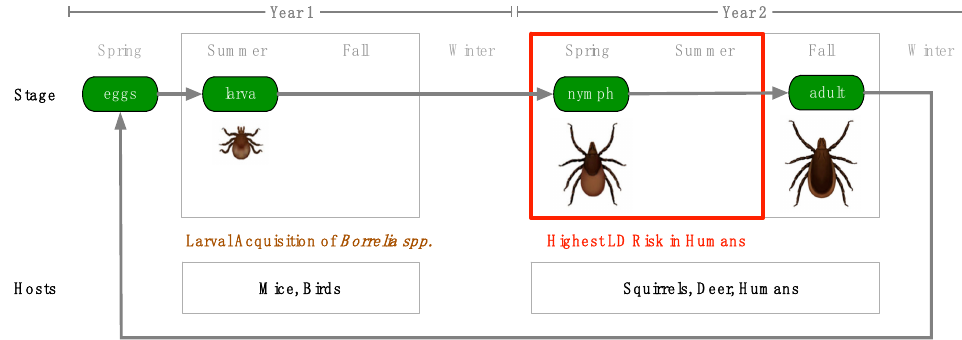
Figure 1. Tick Lifecycle and Host Interaction—The Ixodes scapularis tick lifecycle takes two years and requires three blood meals, one at the larval stage, one at the nymphal stage and one at the adult stage of development. Smaller mammals and birds serve as hosts for blood meals at the larval stage, while larger mammals are hosts during the nymphal and adult stages. Larvae which acquire Borrelia spp. from mice and birds in the summer of their first year can transmit these spirochetes as nymphs in the spring of their second year, infecting humans. For this reason, Lyme disease (LD) risk is highest in the spring and summer.